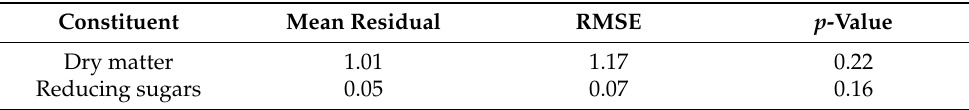
Table 3. External validation (19 samples) of potato quality parameters with the results of the NIR calibration.